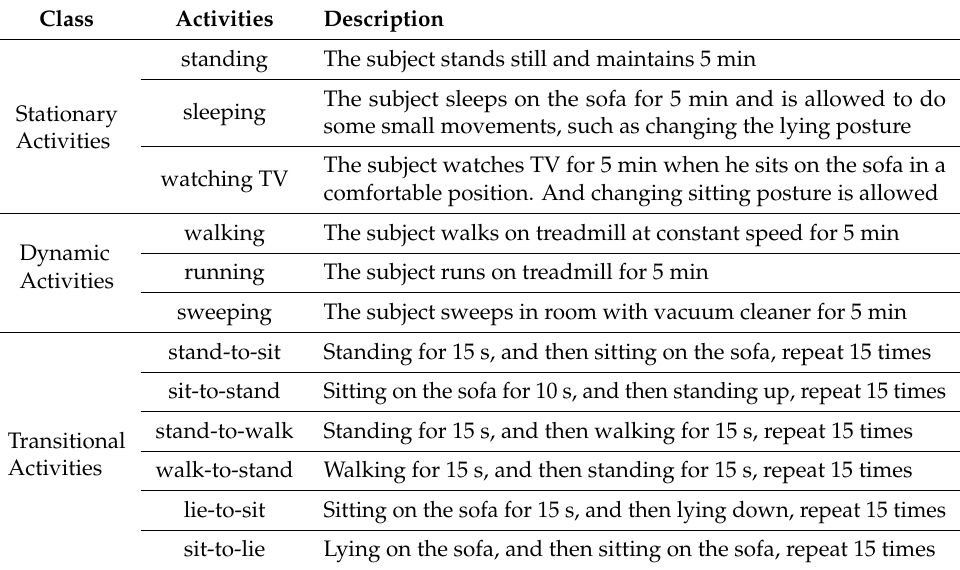
Table 2. The concrete descriptions of twelve human daily